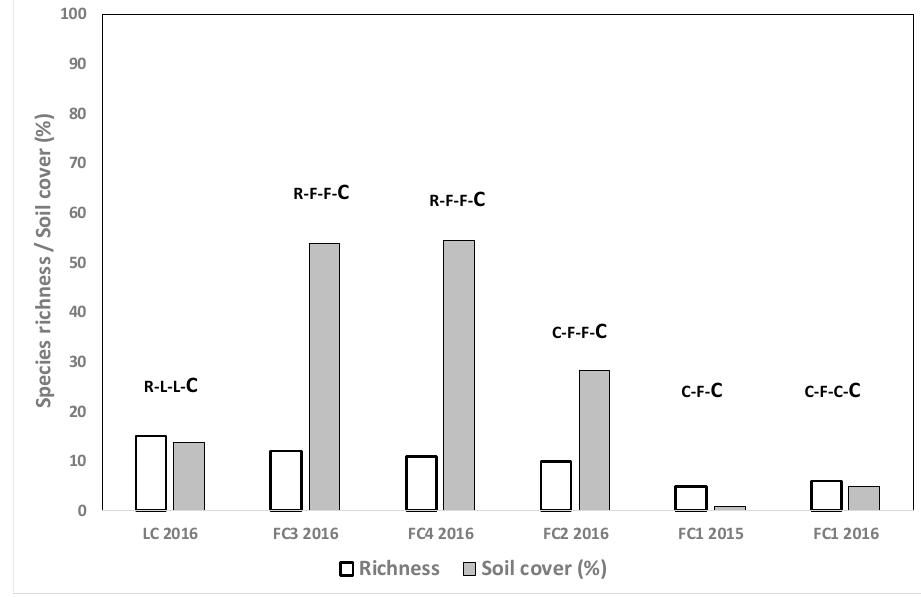
Figure 4. Weed species richness and total weed soil cover (%) for the cereal crops grown in different crop rotation situations in the spring surveys. The letters show the crops from 2013 until the sampling moment, the sampled crop being the last of the rotation (in larger letters). R: rice, C: cereal, F: fescue, L: lucerne.